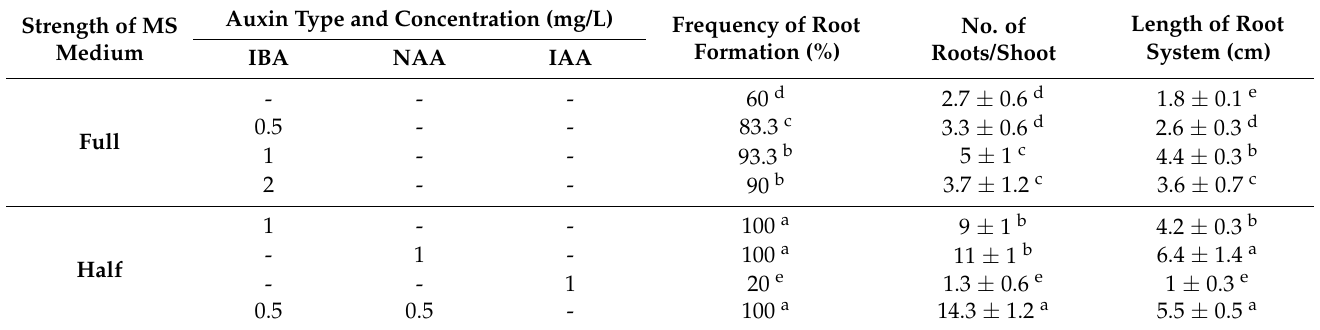
Table 8. Root formation and growth on paulownia microshoots cultured on semisolid full-strength MS medium containing different IBA concentrations or semisolid half-strength MS medium containing 1 mg/L of different auxins for three